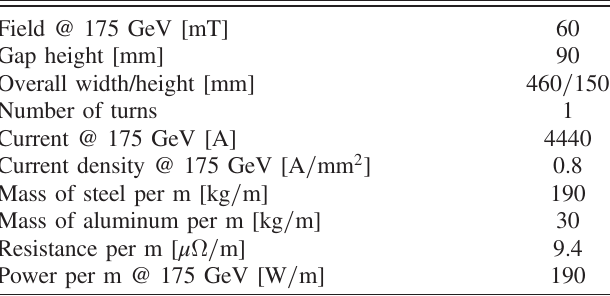
TABLE VIII. Main parameters of the FCC-ee I dipoles.